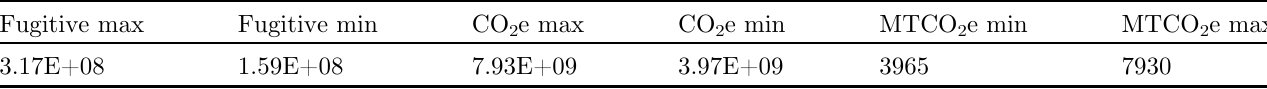
Table 3. Emissions (tonnes) from well leaks for the entire fi eld.